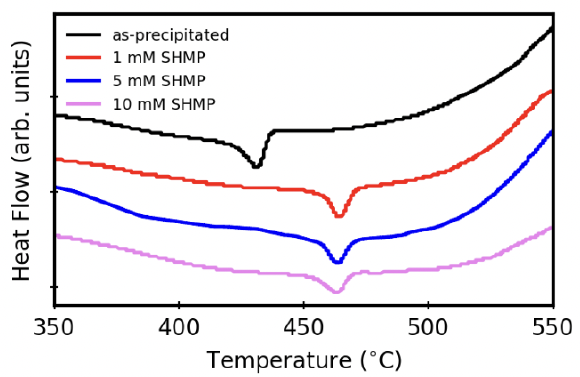
Figure 5. Representative DSC traces for as-prepared and SHMP-treated powders, all at 10 ◦ C/min heating. Endothermic peaks point downward. Data curves are offset along the vertical axis for